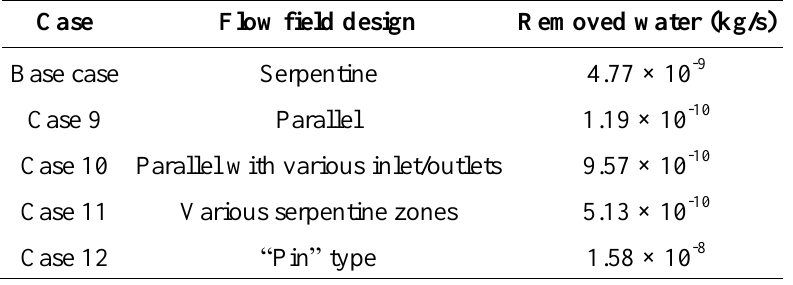
Table 4. Water removal capability for different flow field